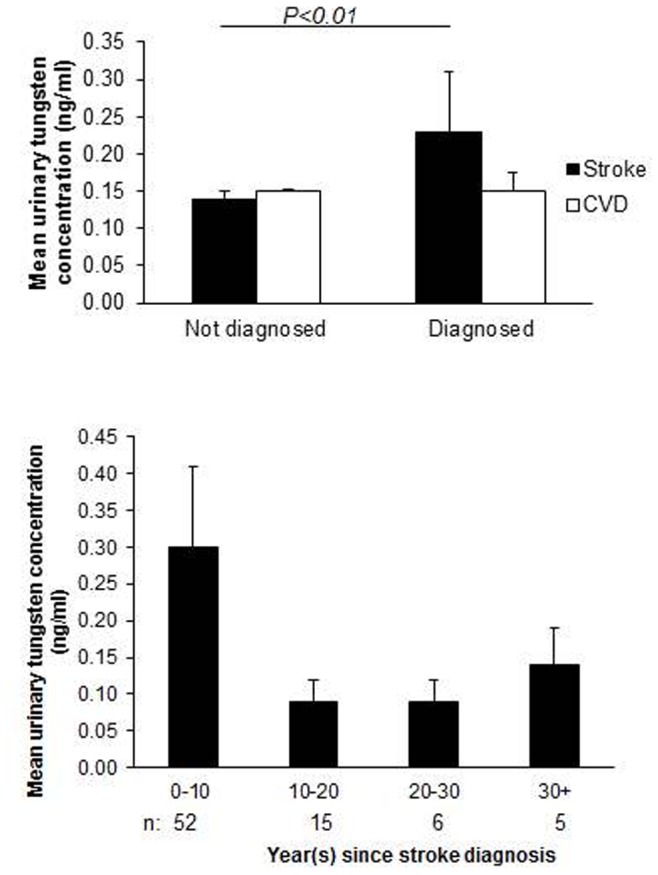
Bar charts representing the mean urinary tungsten concentrations in individuals with and without a self-reported stroke or CVD diagnosis.Error bars represent the 95% confidence intervals and the P value represents the comparison of tungsten concentrations in people with and without a stroke diagnosis.